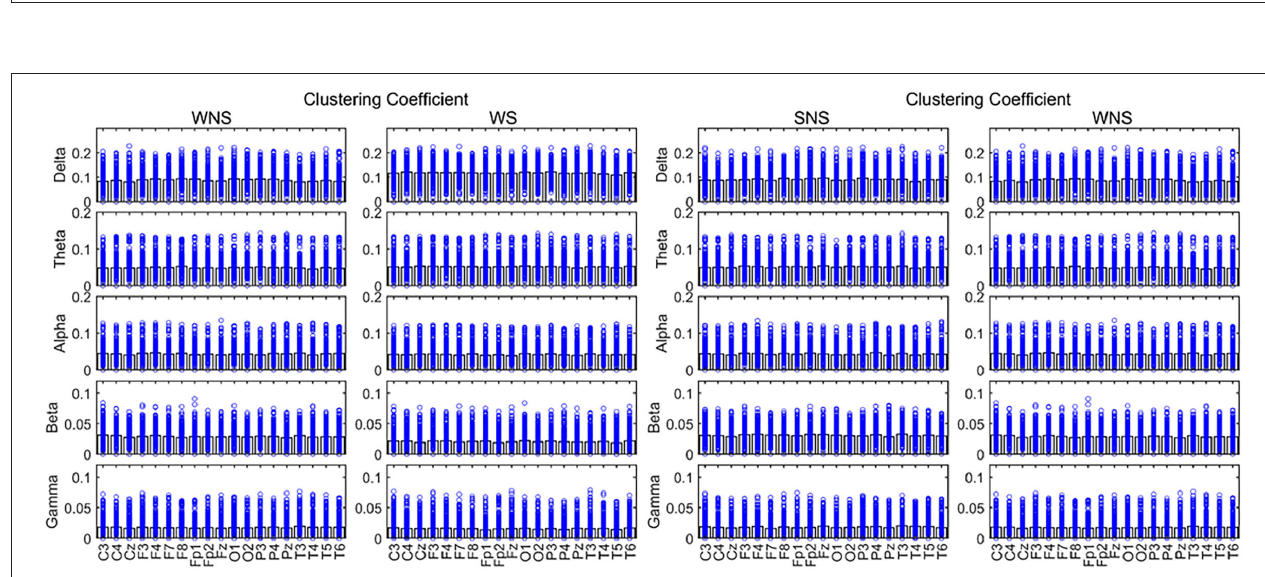
FIGURE 4 | Clustering coefficient (CC) in different frequency bands. Two-sided nonparametric Wilcoxon rank-sum tests were taken. The defense capabilities of slow waves increased ( P < 0.05). The slow waves and the beta band were weaker in local EEG defense capabilities, and the alpha band of Pz was stronger in local networks while patients were awake ( P < 0.05). SNS, sleep period; WNS, awake period; WS, ictal period during